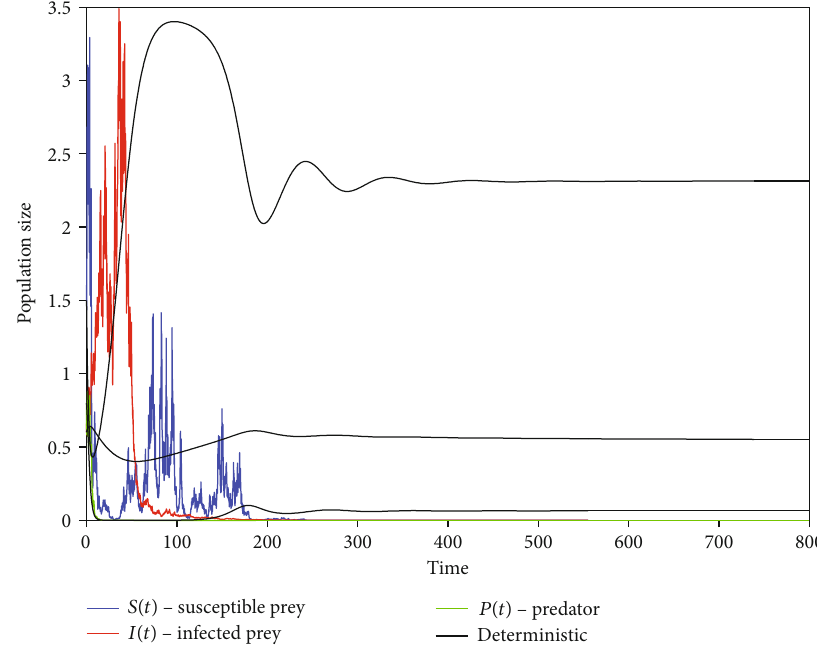
Figure 4: Simulation showing that the solutions of the stochastic system (23) become extinct with σ solutions of the deterministic system (11) are persistent.